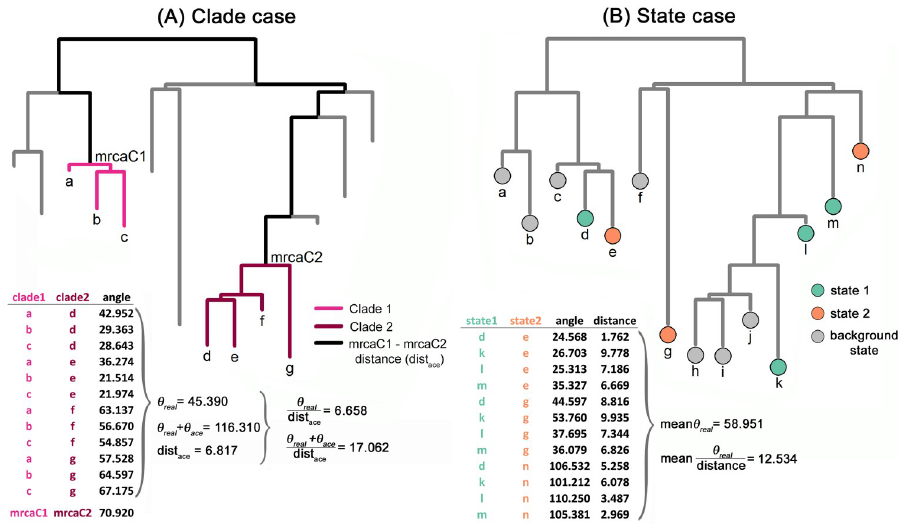
Fig 1. Hypothetical example illustrating how the search . conv function algorithm works. In the clade case (A), given any two monophyletic clades in the tree, the mean angle averaged over all possible combinations of two species (one per clade) is computed. This θ real angle is divided by the distance between the most recent common ancestors to the respective clades, mrca1 and mrca2. Significance is assessed by comparing the result of this procedure to 1,000 randomly generated angles θ random computed between species extracted by chance from the tree, divided by their respective distances. Angles are further computed between phenotypes at the mrcas. These θ ace angles are summed to the corresponding θ real to test whether convergence was already present at the beginning of clade history. Ancestral phenotypes are either estimated by RRphylo or provided by the user according to the fossil record. In the state case (B), θ real are computed as in the clade case, but taking the mean angle between each combination of pairs of species (taken one per state), divided by their distance.